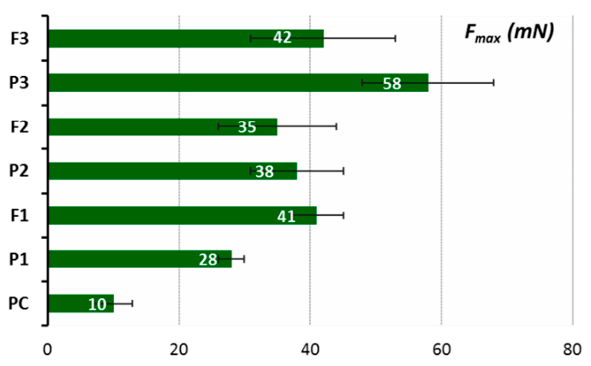
Figure 6. The maximum force of detachment (F max , mN) of placebo (P1–P3) and chitosan tablets with Chelidonii herba lyophilized extract (F1–F3) compared to cellulose acetate paper control (PC) ( n = 4; mean ± SD).